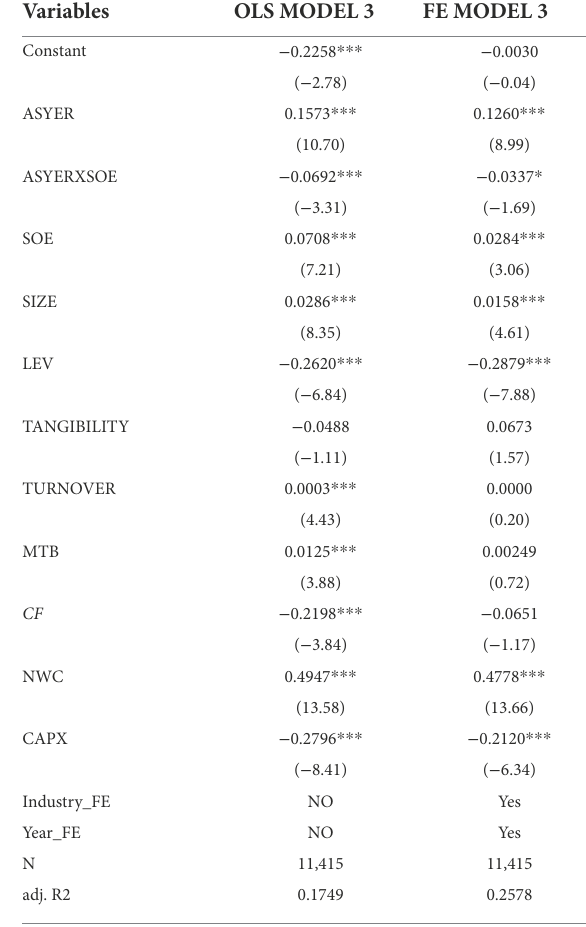
TABLE 6 Information asymmetry and corporate cash holdings — role of state